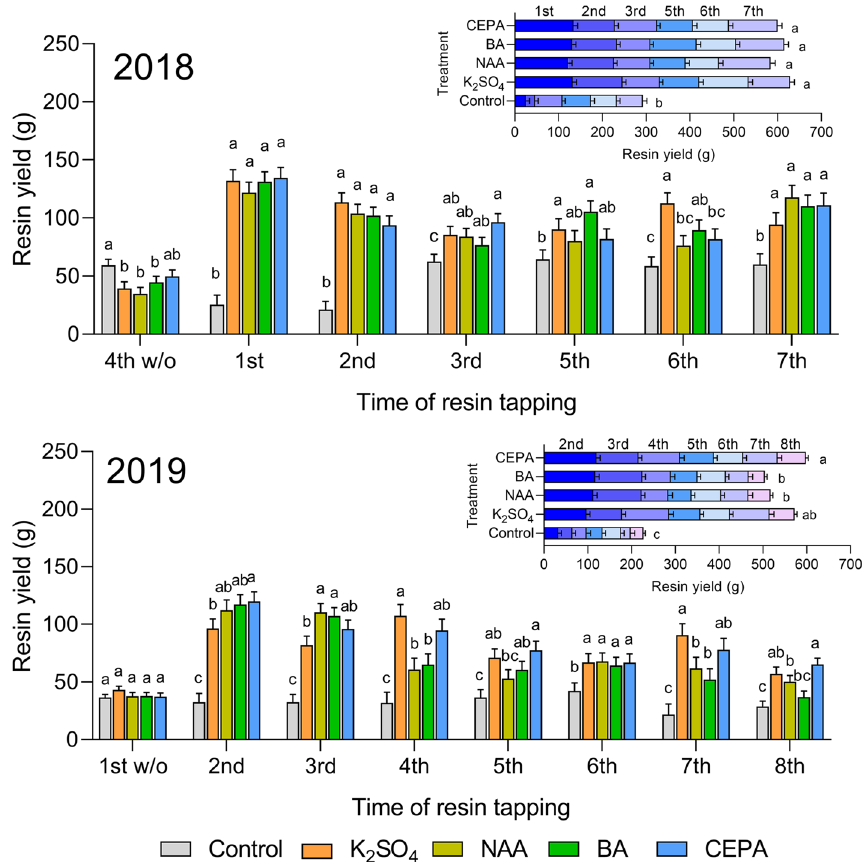
Figure 1. Resin yield of single and total tapping with different resin-stimulating pastes applied. Resin yields of single tapping rounds are shown in the main figures. Resin yields of total tappings are shown in the inset figures. Treatment bars in main figures not sharing a letter are significantly different (Tukey test, P < 0.05). Treatment stacked bars showing total resin production in inset figures not sharing a letter are significantly different (Tukey test, P <